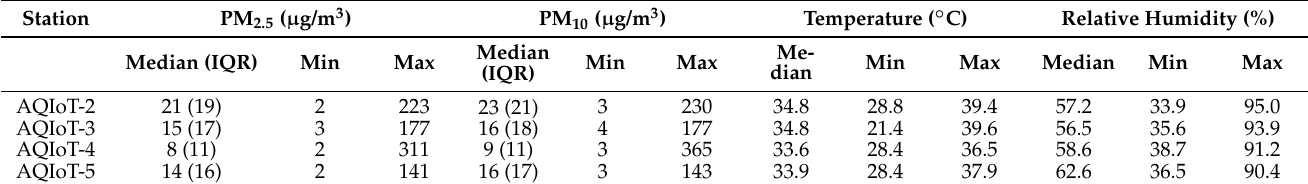
Table 3. Descriptive statistics of meteorological parameters data, and indoor concentration of particu- late matter (PM 2.5 and PM 10 ) .